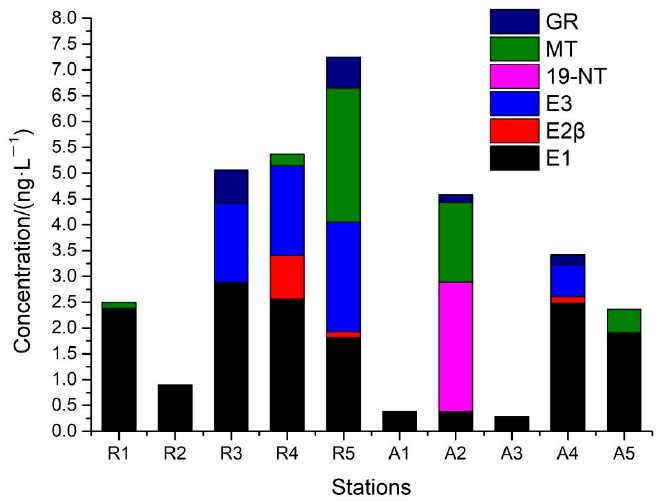
Figure 2. Distribution of steroids in seagoing rivers and aquaculture wastewater.